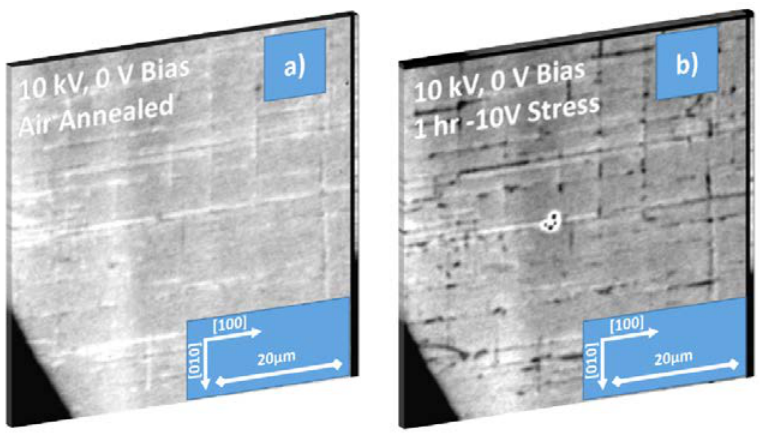
Figure 62. EBIC images of a Pt/SrTiO 3−x contact. All images are taken with a 10 kV beam acceleration. ( a ) was taken at 0 V applied bias to the Pt contact; ( b ) after stressing the air annealed contact at − 10 V for 1 h.